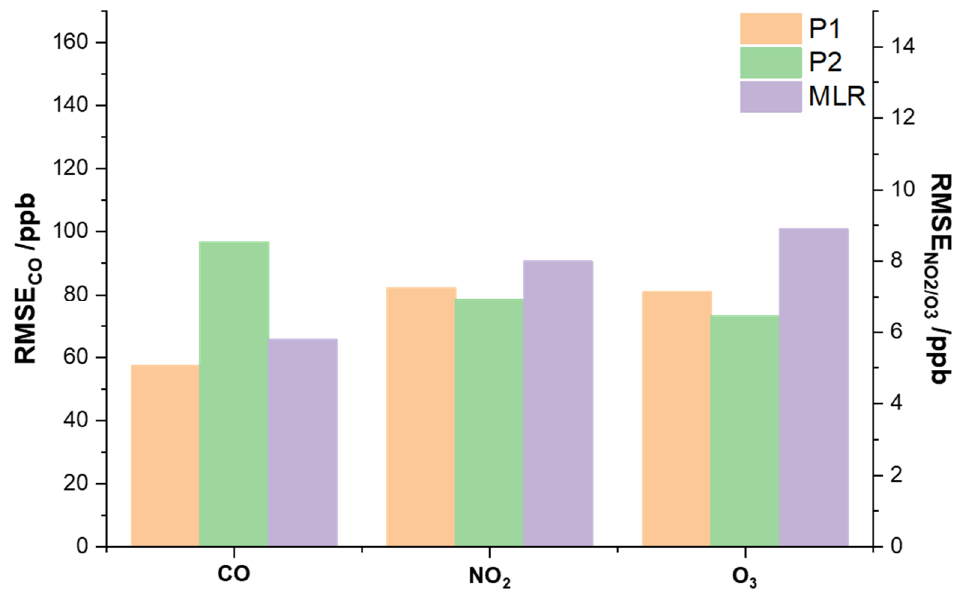
Figure 10. RMSE determined from respective calibration protocols along with the conventional multi-linear regression model: Protocol 1 (P1) refers to the Personal Exposure Kit (PEK) calibrated with standard gases under laboratory conditions; Protocol 2 (P2) refers to the PEK calibrated by collocation with government reference instruments and Method 1 (MLR) refers to raw sensor signal tuned by the multi-linear regression in the same circumstances.